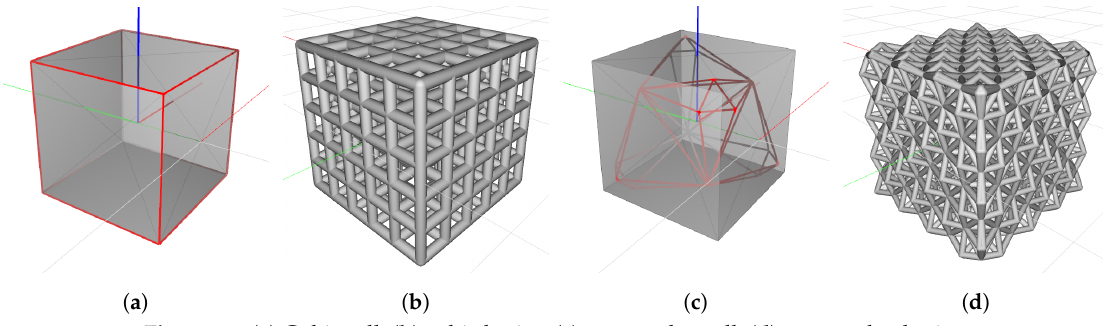
Figure 21. ( a ) Cubic cell; ( b ) cubic lattice; ( c ) tet oct edge cell; ( d ) tet oct edge lattice.